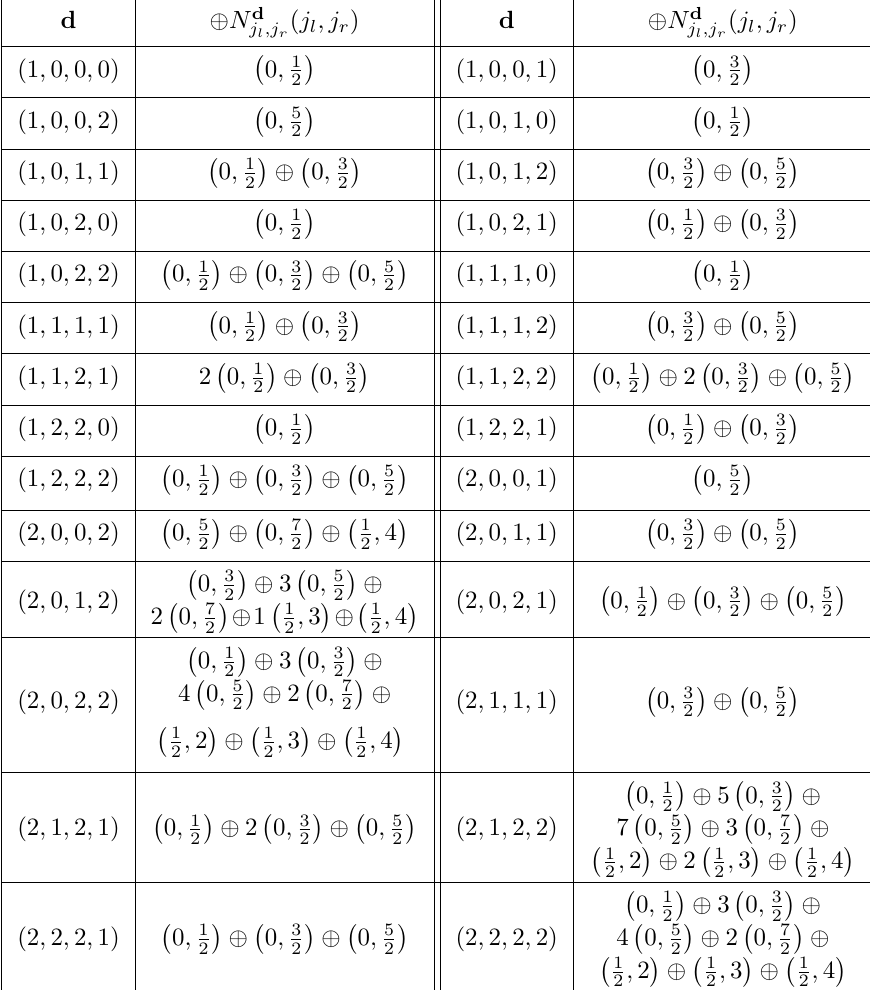
Table 30. BPS spectrum of the pure SU(4) 8 theory for d i ≤ 2 . Here, d = ( d 1 , d 2 , d 3 , d 4 ) labels